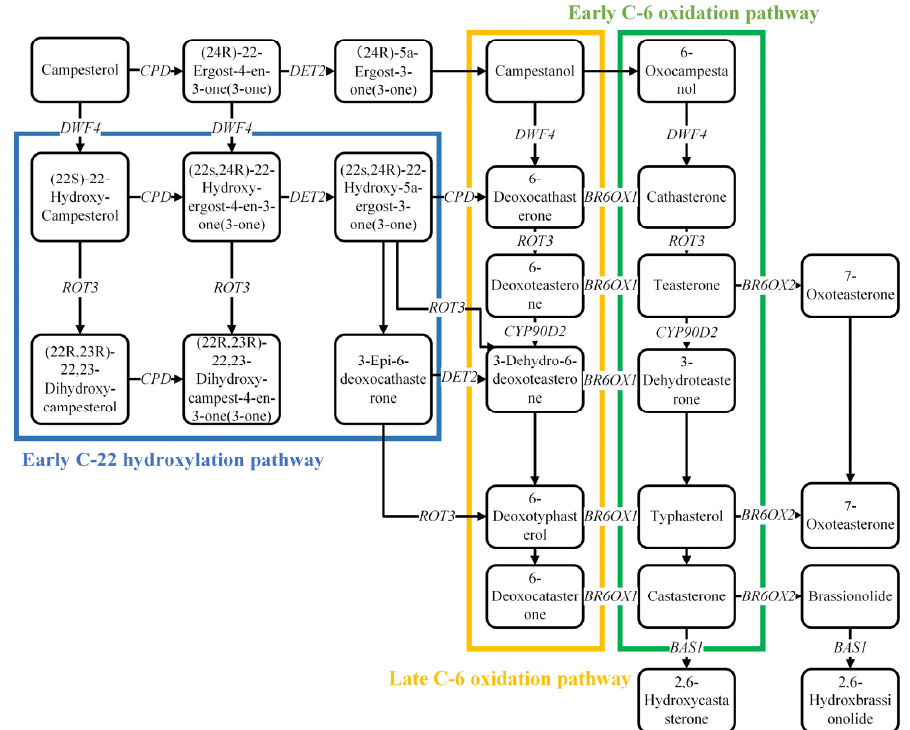
Figure 1. The biosynthesis and metabolism pathways of BR. The blue frame expressed the early C-22 hydroxylation pathway in BR biosynthesis, the yellow frame expressed the late C-6 oxidation pathway, and the green frame expressed the early C-6 oxidation pathway. There are six rate-limiting enzymes of BR biosynthesis, namely CPD , DWF4 , ROT3 , DET2 , BR6OX1 , BR6OX2 ; and one rate-ling enzyme of BR metabolism, namely BAS1